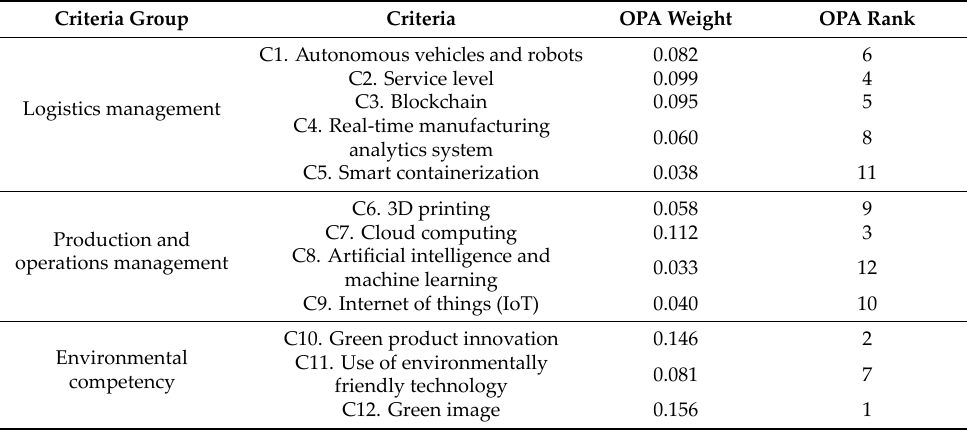
Table 6. The weights of criteria from the OPA